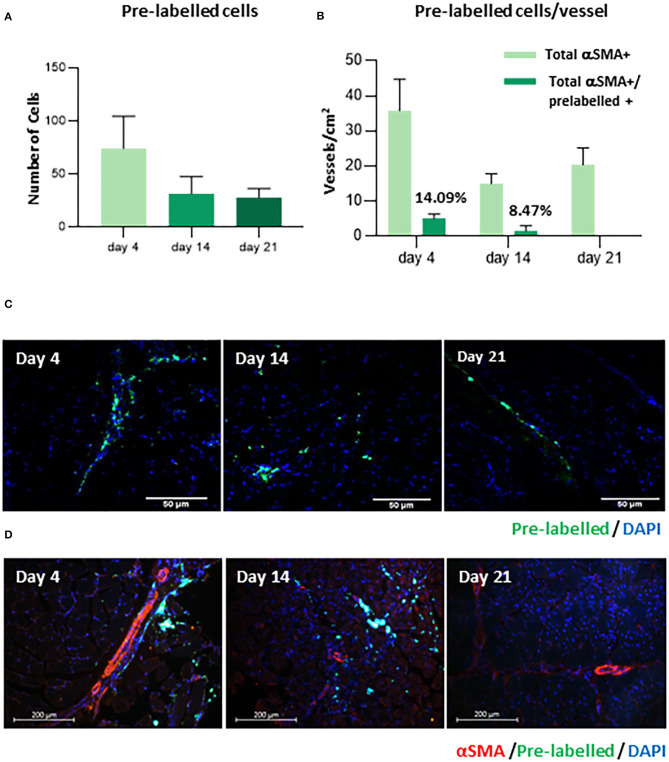
Detection of human pre-labeled BM-MNC. (A) The graph represents the number of cells pre-labeled with LuminiCell Tracker™ 540, detected on day 4, 14, and 21 by IHC. (B) The proportion of vascular vessels detected on day 4, 14, and 21, incorporating REX-001 pre-labeled cells (pre-labeled+/αSMA+) is shown. (C) Representative IHC images confirming the presence of pre-labeled cells (green) within the tissue and also (D) in the vicinity of vascular vessels (α-SMA staining, reed), are shown for mice sacrificed on day 4, 14, and day 21.